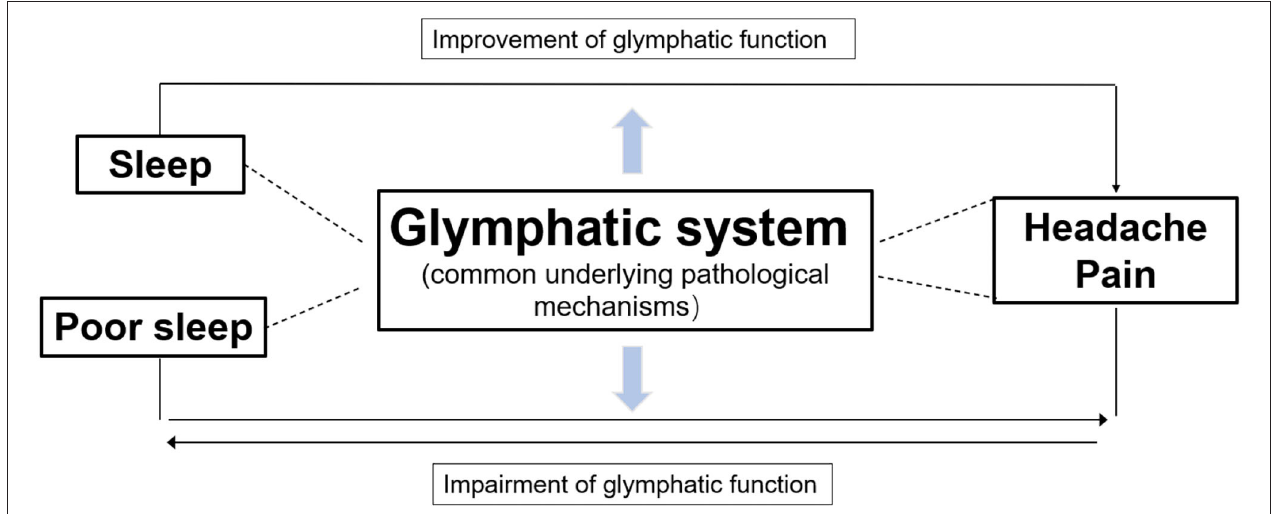
FIGURE 4 | Diagram illustrating the relationship of three parts. GS dysfunction is a common underlying pathological mechanism of sleep disturbances and headache pain. Glymphatic flow, the clearance of waste products, and nutrient transportation can be improved during sleep, which may alleviate headaches. In contrast, poor sleep and headaches affect each other and may be connected indirectly, whereby both impairing glymphatic function, which further exacerbates both conditions.